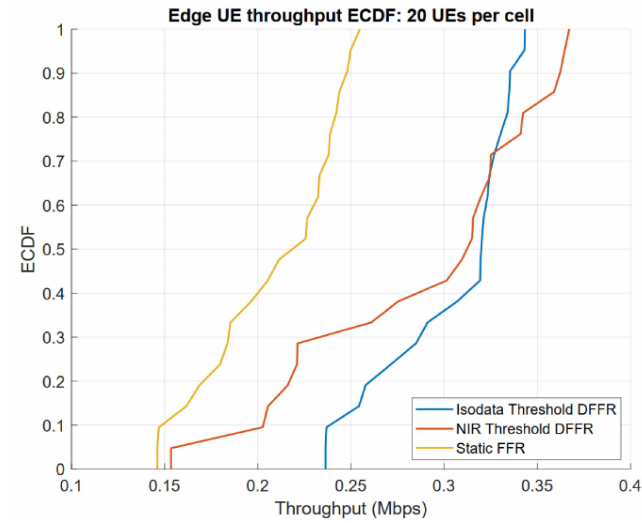
Figure 8. Edge UE throughput ECDF for 20 UEs per cell.